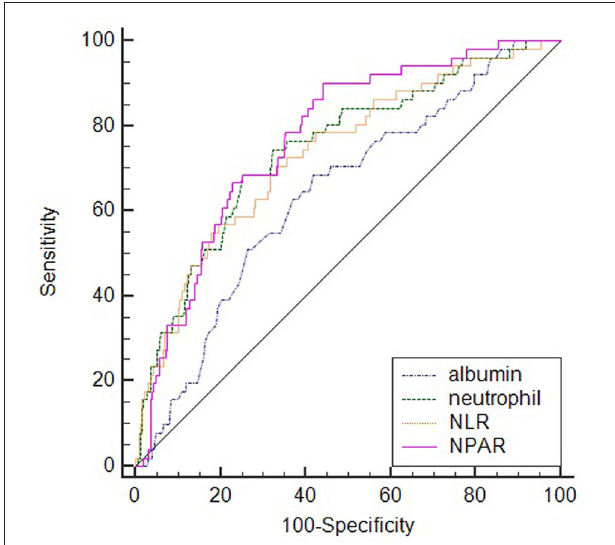
FIGURE 2 | Comparison of predictive value between NPAR and other indicators in the prediction of